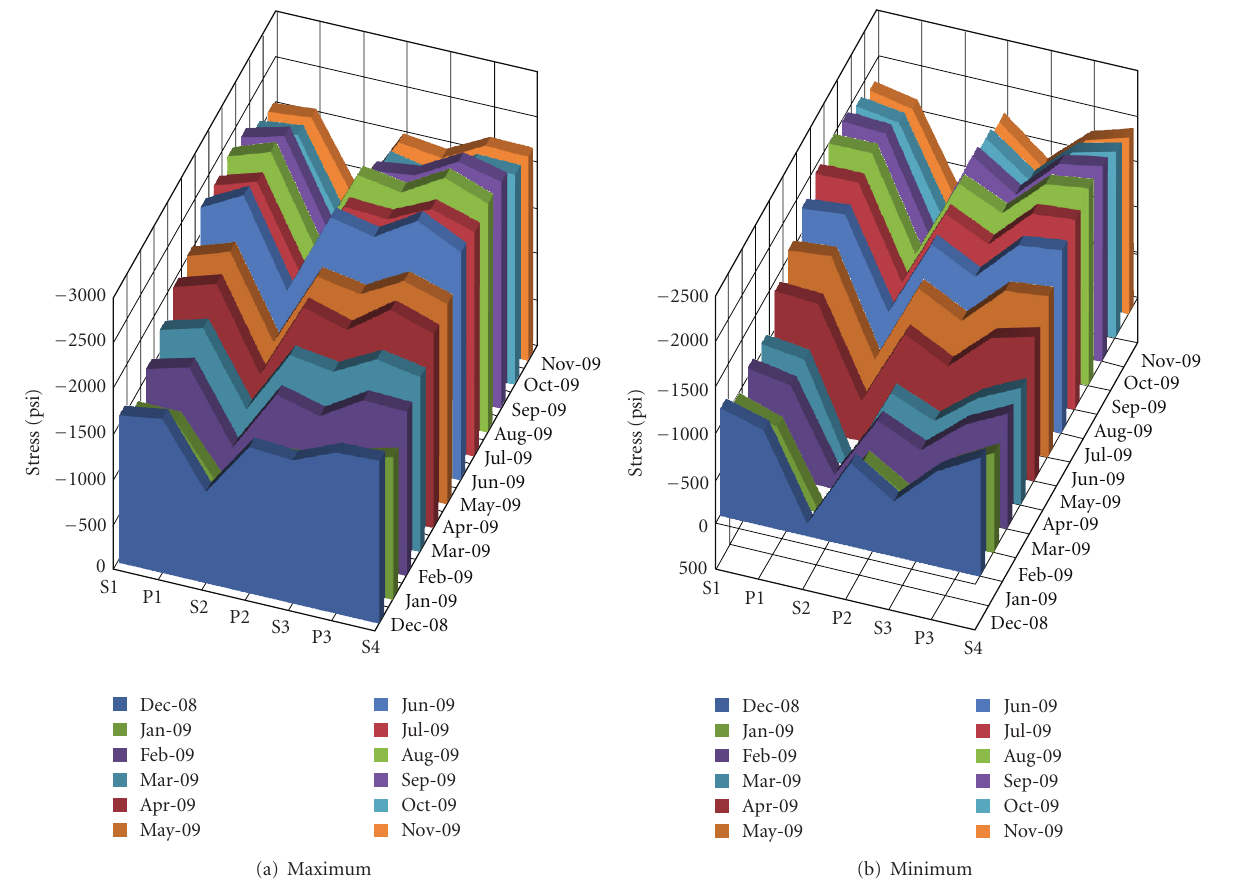
Figure 11: Maximum and minimum longitudinal stresses (psi)—south